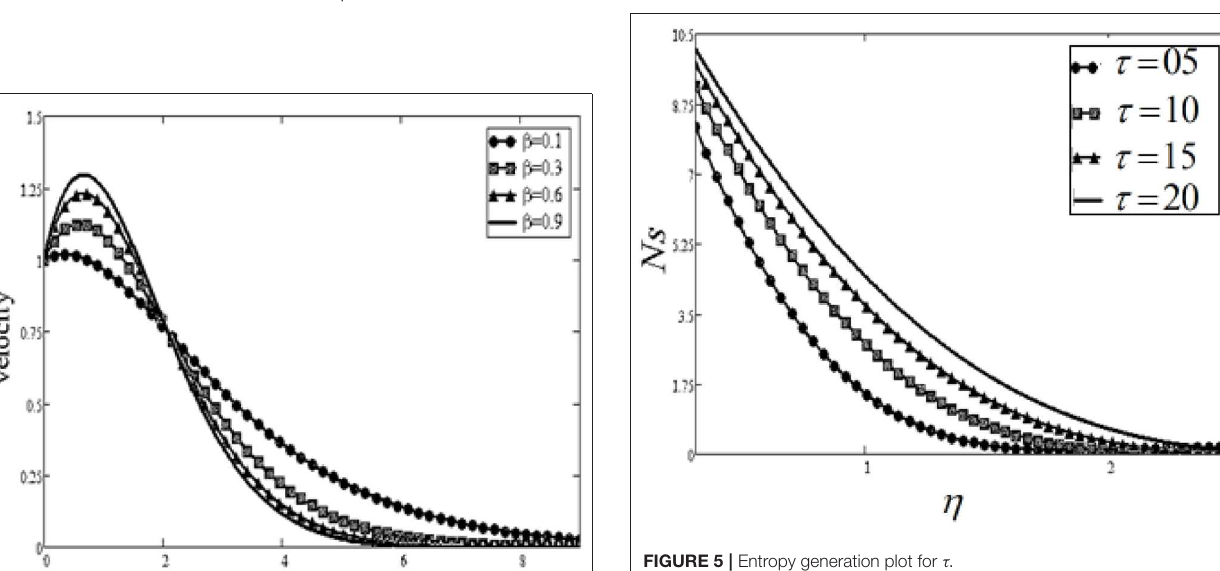
FIGURE 5 | Entropy generation plot for τ .